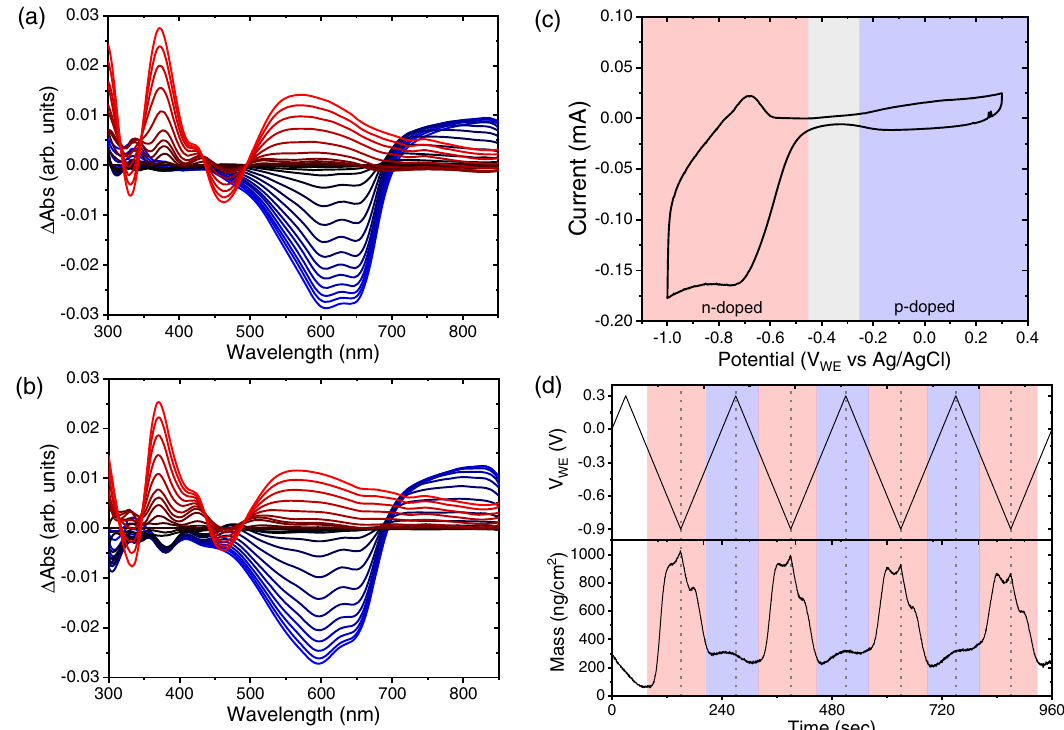
π (cid:4) π * interactions peaks at 600 – 650nm 34 . In the PrC 60 MA red curves, the broad absorptionchange isdueto theformationof aradicalanionthatstretchesintothe NIRregion 61,62 .Asthe HOMO of p(g2T-TT)and LUMO ofPrC 60 MA are ~0.7eVapart (Supplementary Fig. 6), the changes in absorption for each of the components are independent and spectrally resolved. This is also manifested in c Cyclic voltam- metryof the ambipolar 95:5 blend in anEQCM cell at 0.1V/sec,showing the p- and n-doped current as well as a “ neutral ” zone where there is no doping. d Mass changes in the 95:5 blend while performing CV in an EQCM cell at 0.01V/sec, red areasbelong to PrC 60 MA response with injection/expulsion ofK + cations, and blue to p(g2T-TT) response with injection/expulsion of Cl -